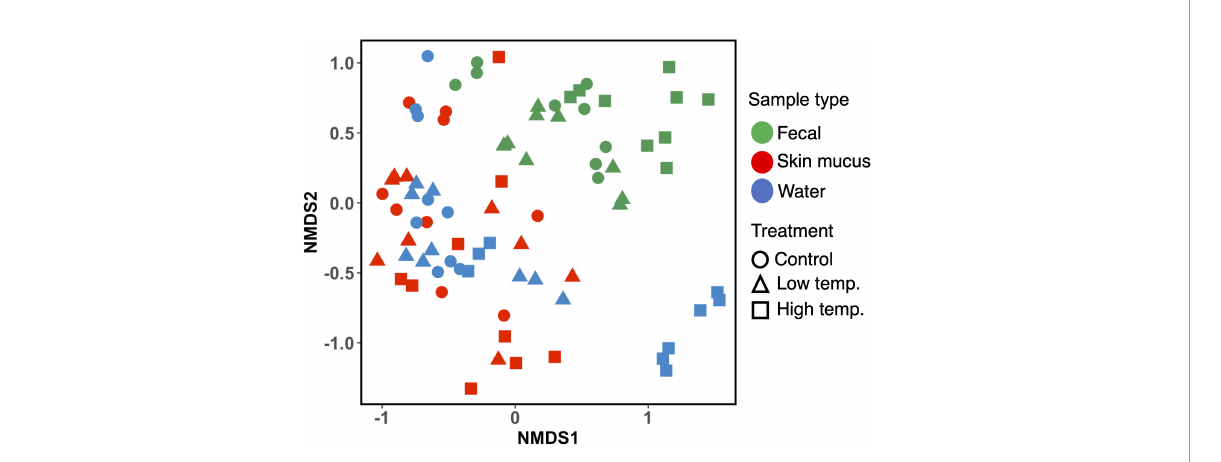
FIGURE 6 Nonmetric multidimensional scaling (NMDS) ordination plots based on Bray – Curtis distance showing bacterial community dissimilarity among fecal, skin mucus, and water samples. Ordination plots show the clustering of bacterial communities according to the sample type and temperature treatment. Each sample is color-coded according to the sample type (green= fecal, red= skin mucus, and blue= water) and plotted according to the temperature treatments (circle= control, triangle= low, and square= high temperature).